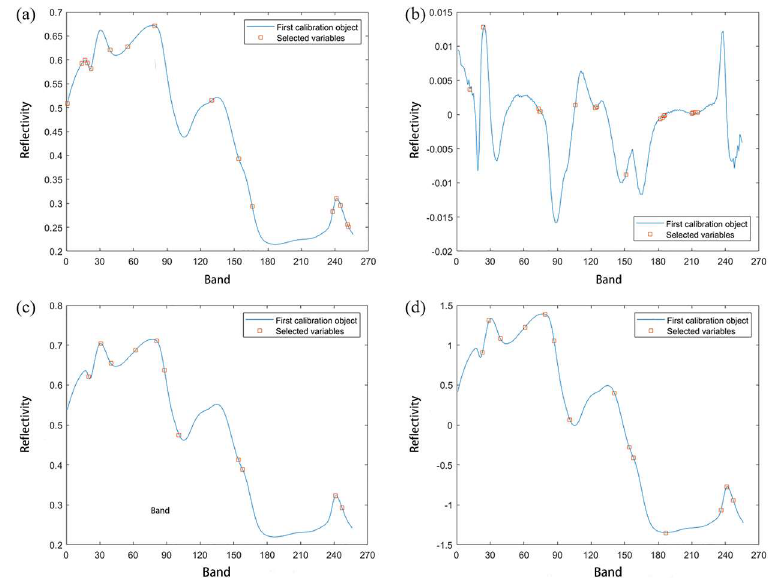
Figure 5. Extracting results of the characteristic wavelength.